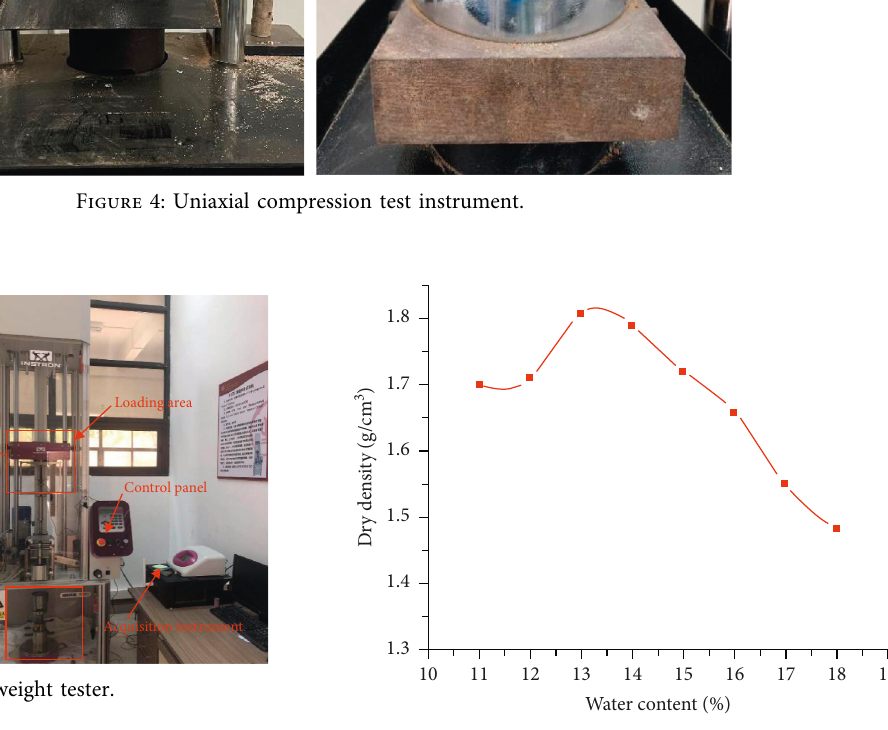
Figure 6: Optimal water content